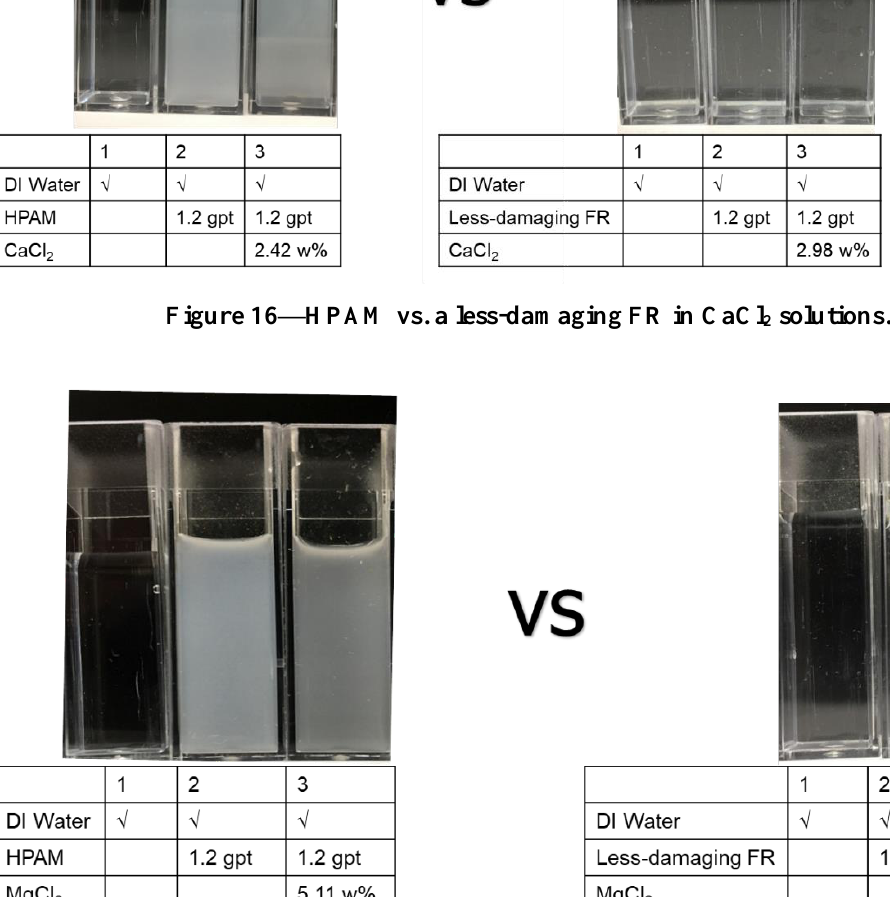
Figure 17—HPAM vs. a less-damaging FR in MgCl